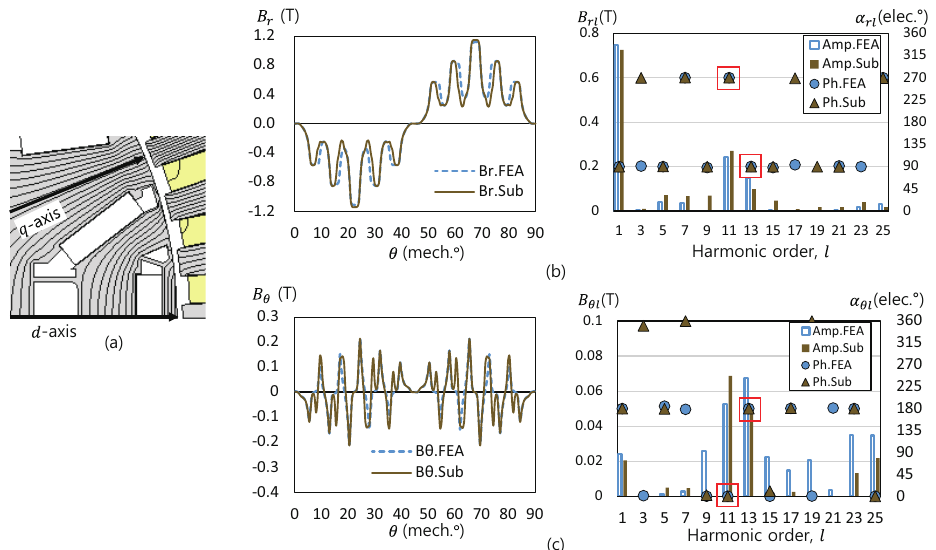
Figure 4. Comparisons of instantaneous air-gap fields when the reluctance torque ripple is zero: ( a ) flux lines, ( b ) radial fields, and ( c ) circumferential fields. Similar results are obtained in Figure 5 for ω r t = 5.75 ◦ with the largest torque ripple. Note again that the harmonic phases agree